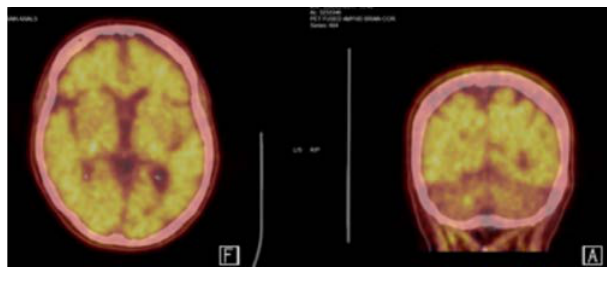
Figure 4. Positron emission tomography imaging with 18F- Flubetapir reveals no asymmetry in tracer